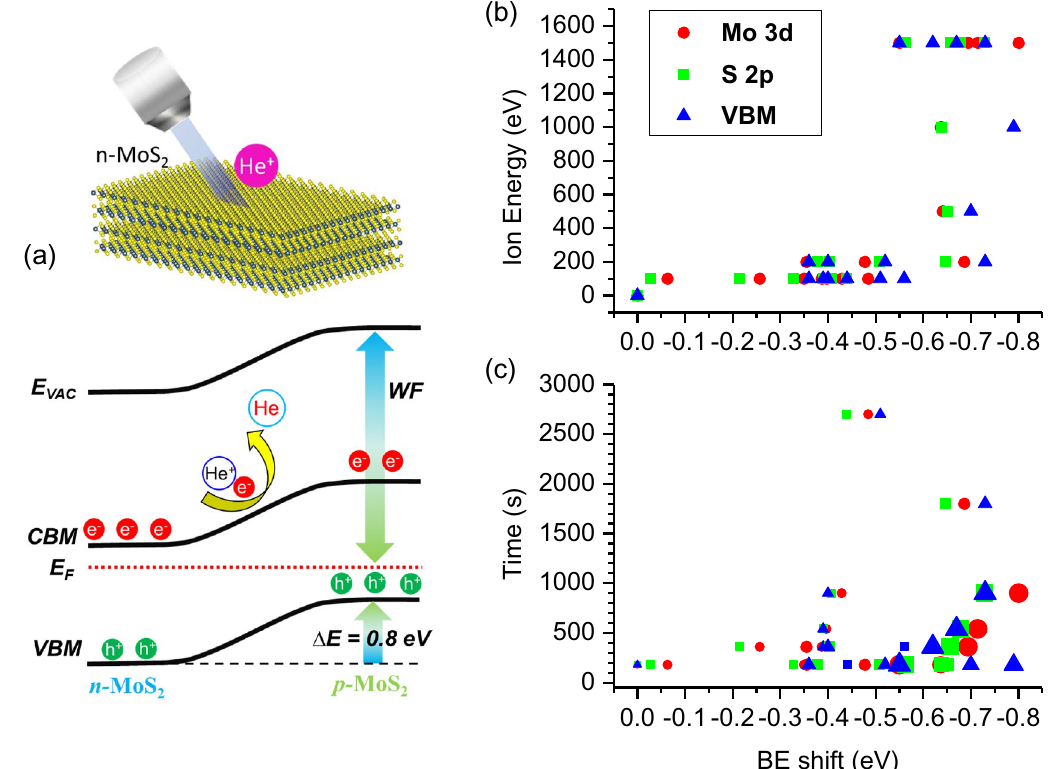
Figure 1. ( a ) Diagram depicting the conversion of n-type MoS 2 to p-type via the downward shifts of Fermi energy (E F ) level and the increase in the work function (WF) from the electron capture of the He + ion irradiation on the MoS 2 surface (inset). ( b , c ) The negative binding energy shifts of Mo 3 d , S 2 p , and valence band photoemission spectra depend on the ion energy ( b ) and irradiation time ( c ) of He + ion irradiation. ( c ) Symbol size indicates the increase of the ion energy from 0.1 eV (left) to 1.5 keV